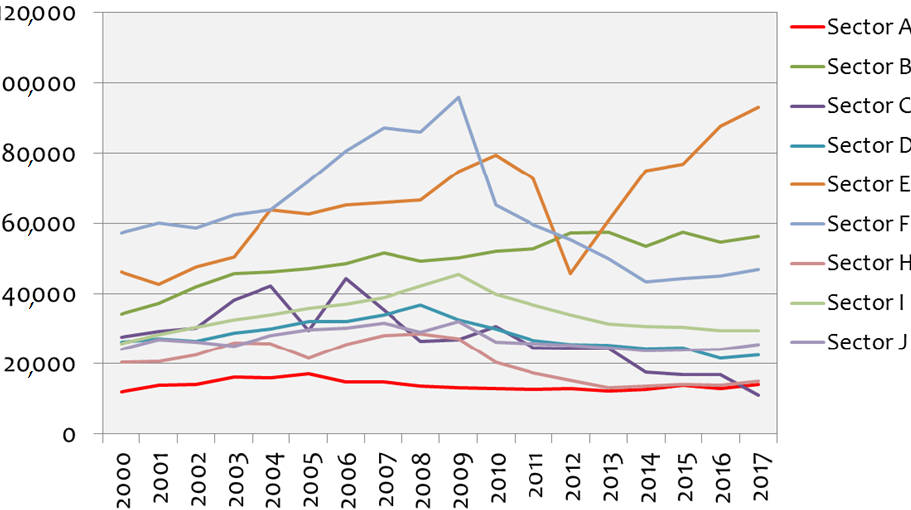
Figure 3. Line diagrams with the sectorial GVA per labor unit (pLU) time-series of Greece, shown at the national level, for the period 2000–2017. GVA prices are measured in EUR/LU (constant prices on 2008 basis).